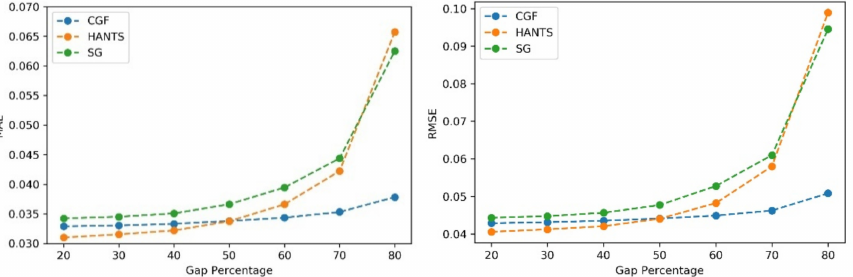
Figure 7. The performance of the NDVI reconstruction model with different gap fractions